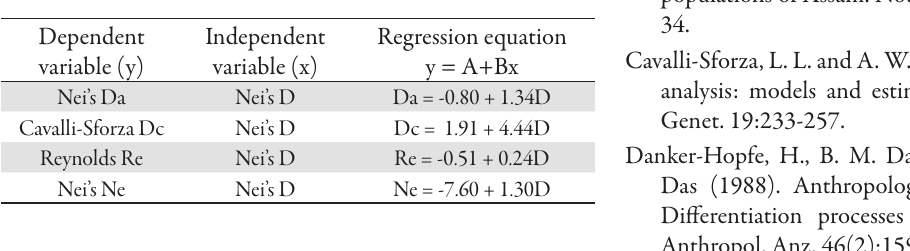
Tab. 4. Linear regression equations of different distance measures on Nei’s